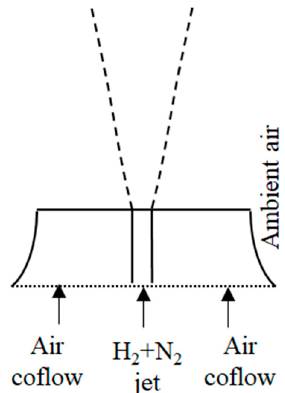
Figure 1. Sketch of experimental set-up of Sautet and Stepowski [43].